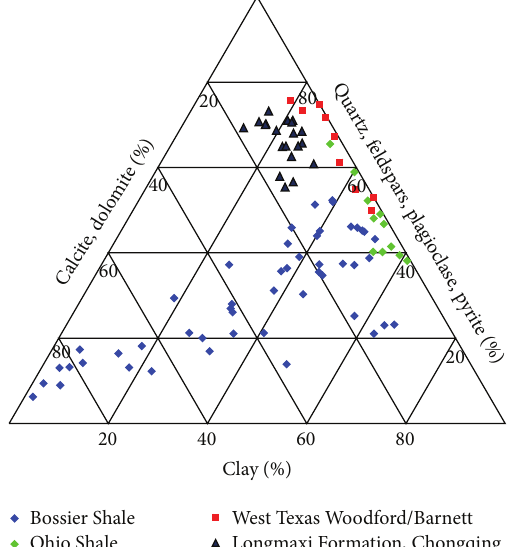
Figure 3: Comparison of the mineral compositions of shale forma- tions (the statistical data for Bossier Shale, Ohio Shale, and West Texas Woodford/Barnett are taken from